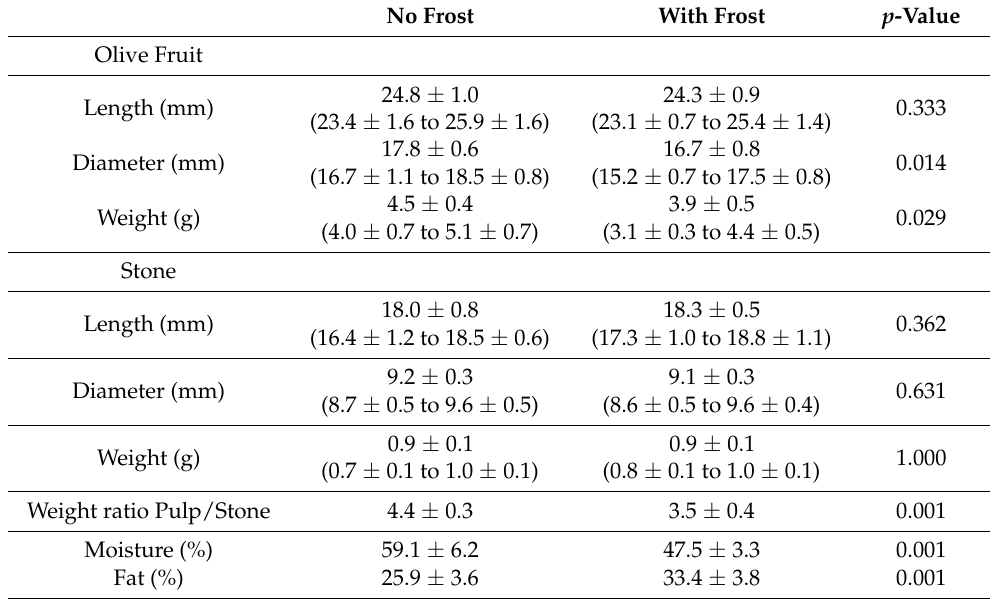
Table 1. Morphological characteristics of olive fruit and stone, moisture, and fat contents of cv . Santulhana of olive fruits affected or not affected by frost (mean ± standard deviation; minimum and maximum values in